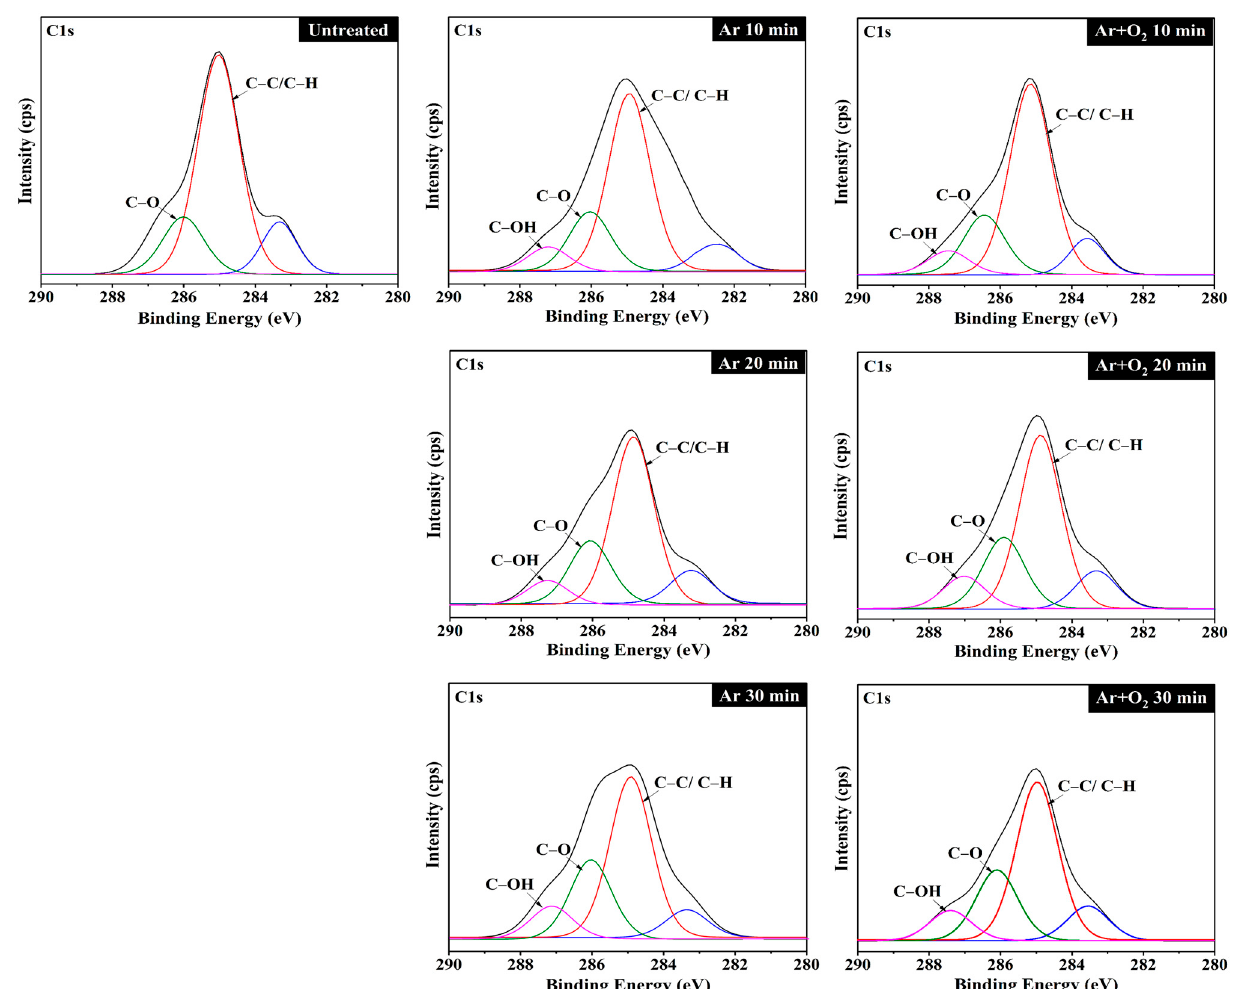
Figure 5. XPS spectra of BFs treated with Ar and Ar + O 2 gas plasma for various treatment